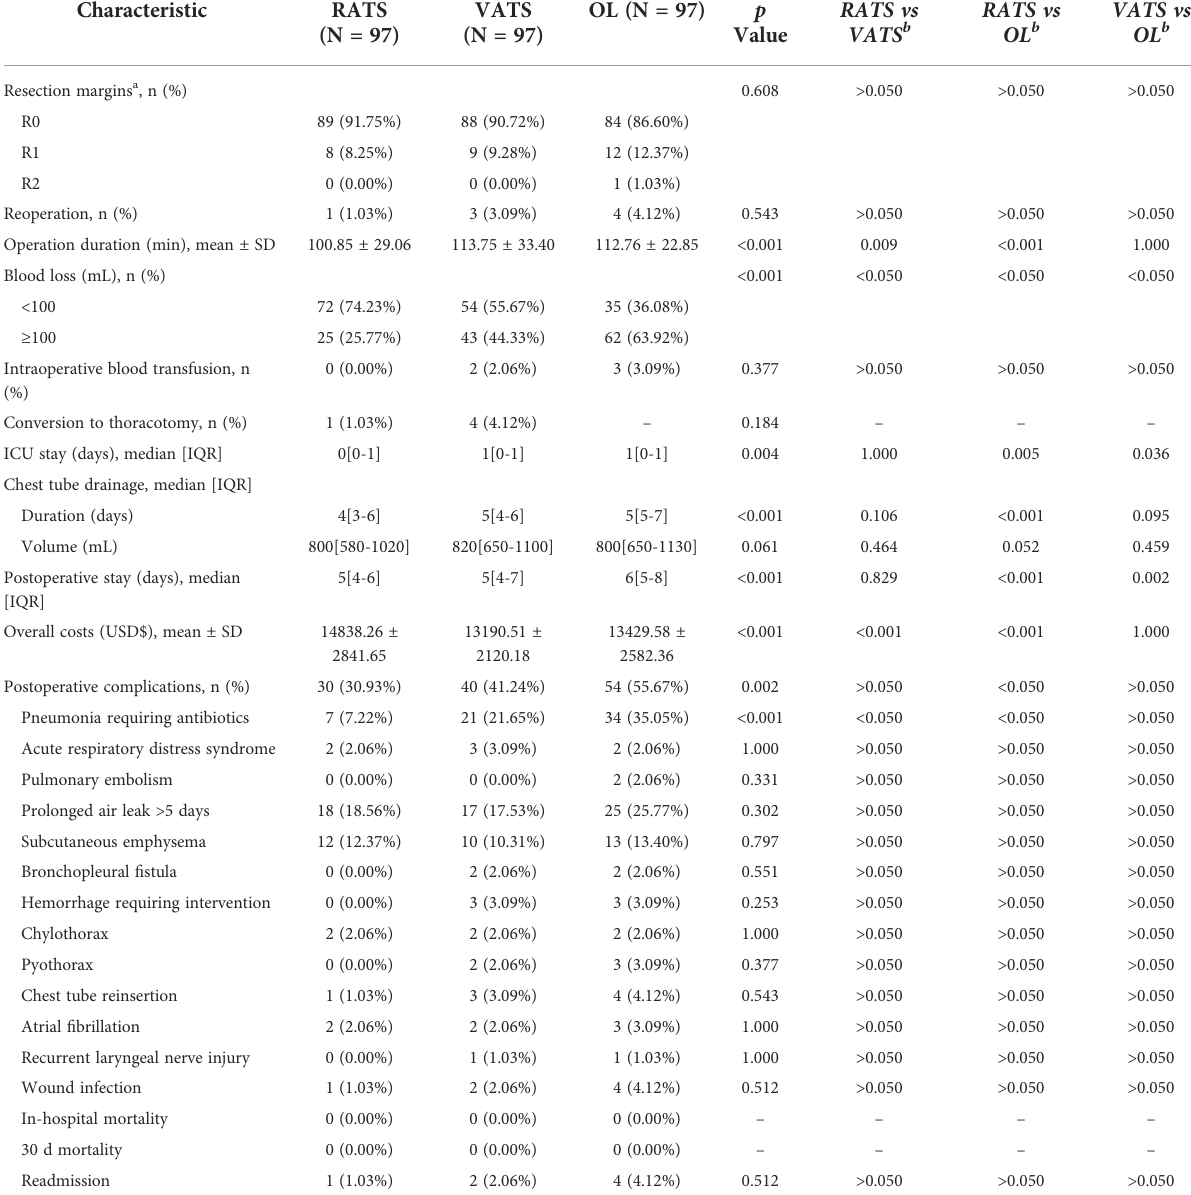
TABLE 3 Perioperative outcomes of matched